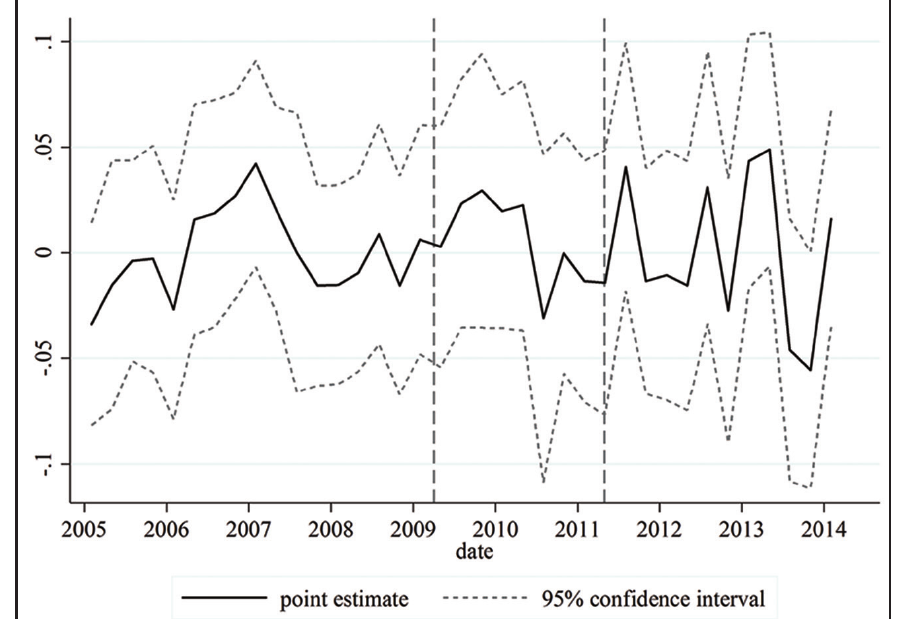
Time-varying estimate of policy effect on number of new